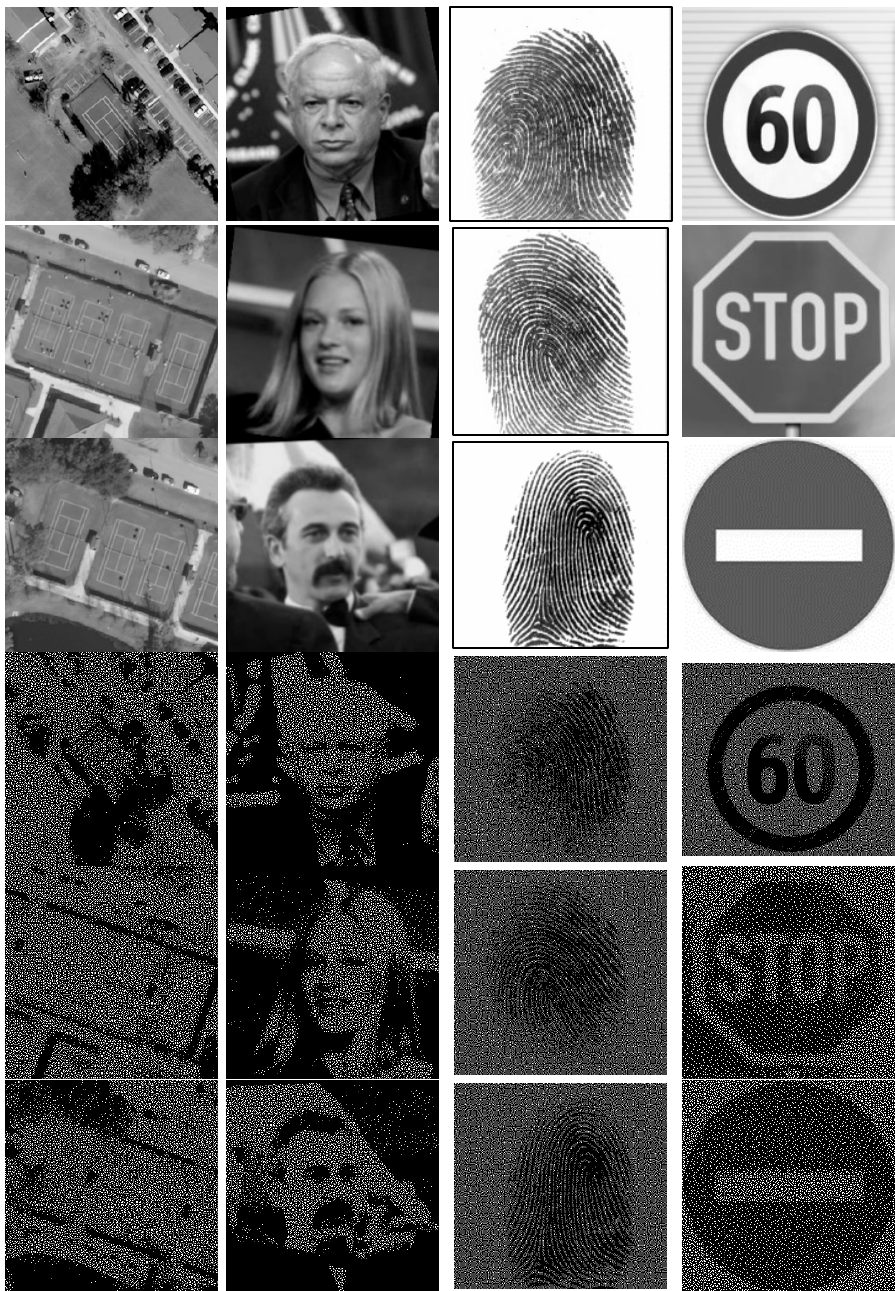
Figure 3. Encryption and decryption experiment based on the proposed EVCS. The first three rows are three randomly selected samples, and the last three rows are corresponding decrypted images.